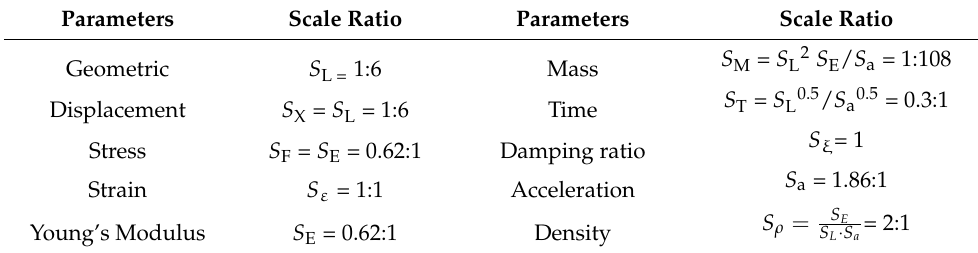
Table 4. Comparison of the natural frequencies of the structure before the main earthquake (Hz).